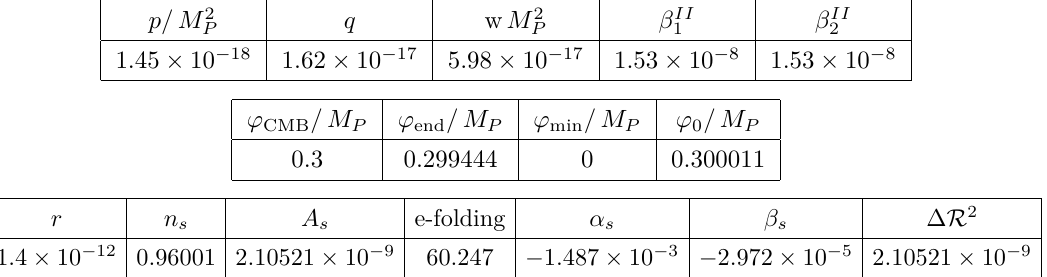
Table 3. Benchmark values for sextic potential ( ϕ min is the minimum of potential eq. (2.45)).